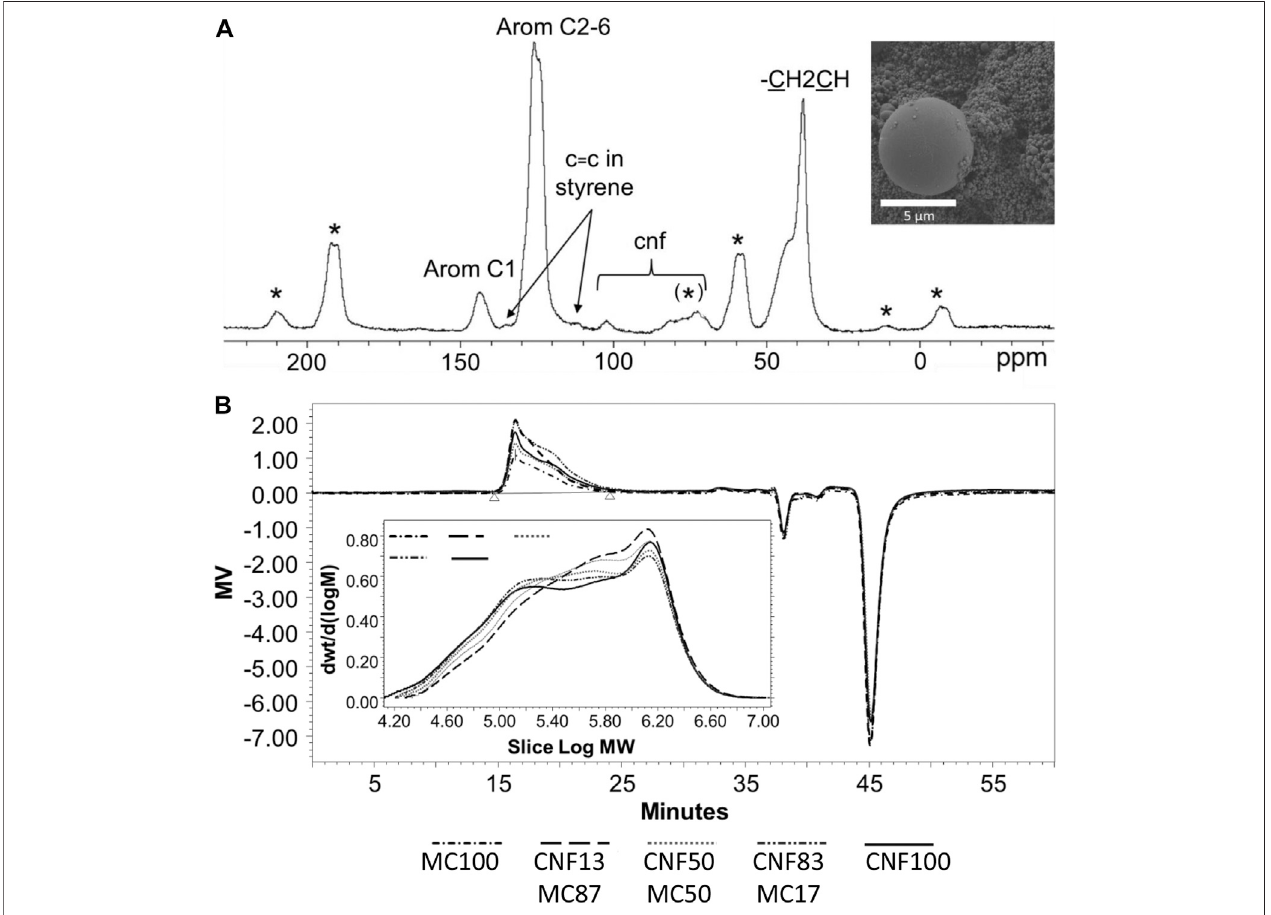
FIGURE 4 | (A) : 13 C NMR spectrum of the sample CNF50MC50 showing the formation of polystyrene. (B) : SEC chromatograms of all samples listed in Table 4 . The insert shows the molar mass distributions of the corresponding samples.